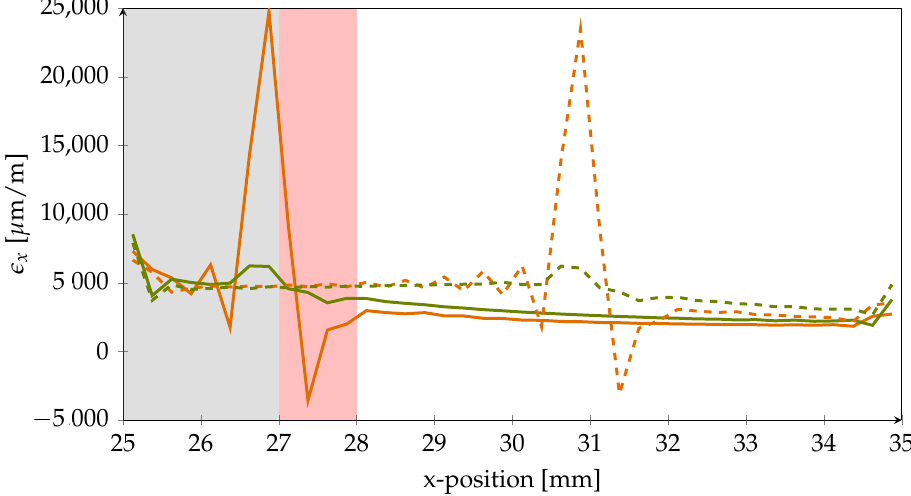
Figure 6. Nominal strain in the x-direction in PVDF at different positions. The orange lines correspond to the upper PVDF-adhesive-interface. Green lines represent the lower PVDF-CFRP-interface. Results for the two different crack lengths can be distinguished by the line type (solid = 27mm, dashed = 31mm). The grey background marks the simulated artificial disbond, while the red area is the resulting destructive zone for sensor structures because of high strain gradients.